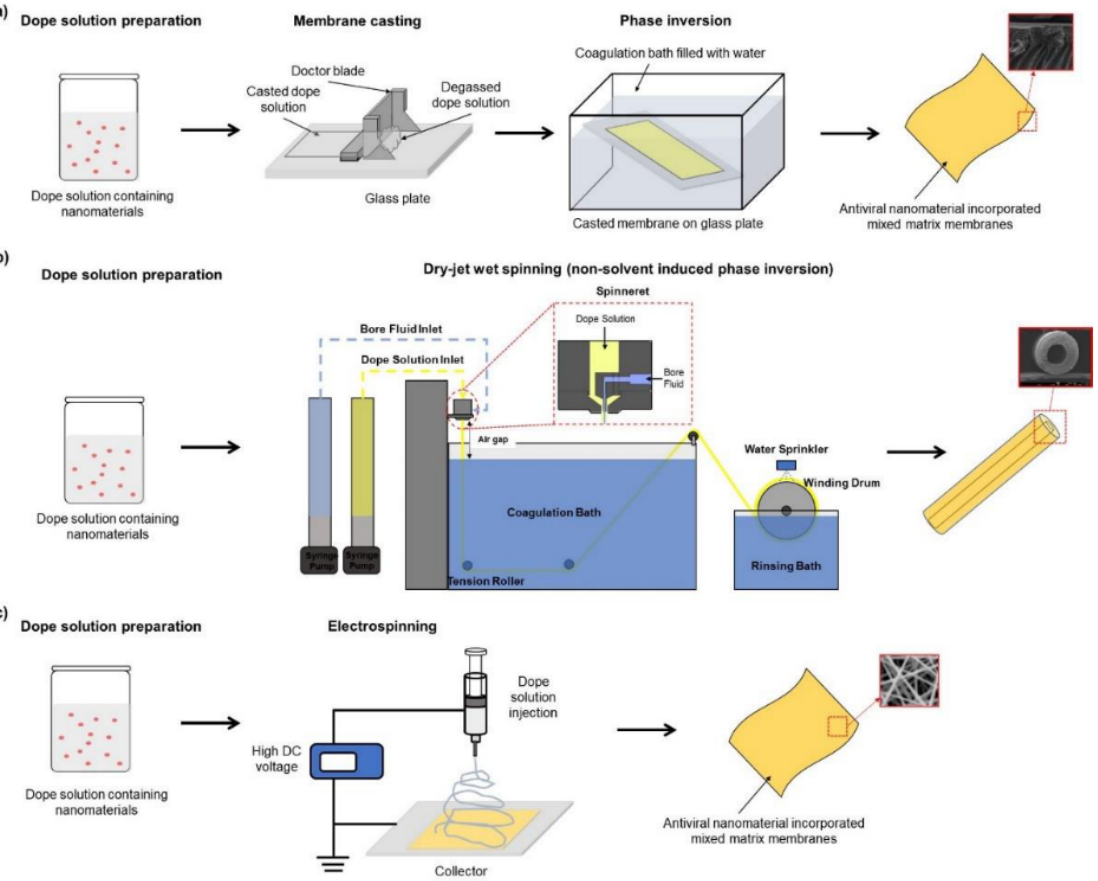
Figure 5. Three types of phase inversion: ( a ) dry-jet wet spinning, ( b ) non-solvent-induced phase separation, and ( c ) electrospinning